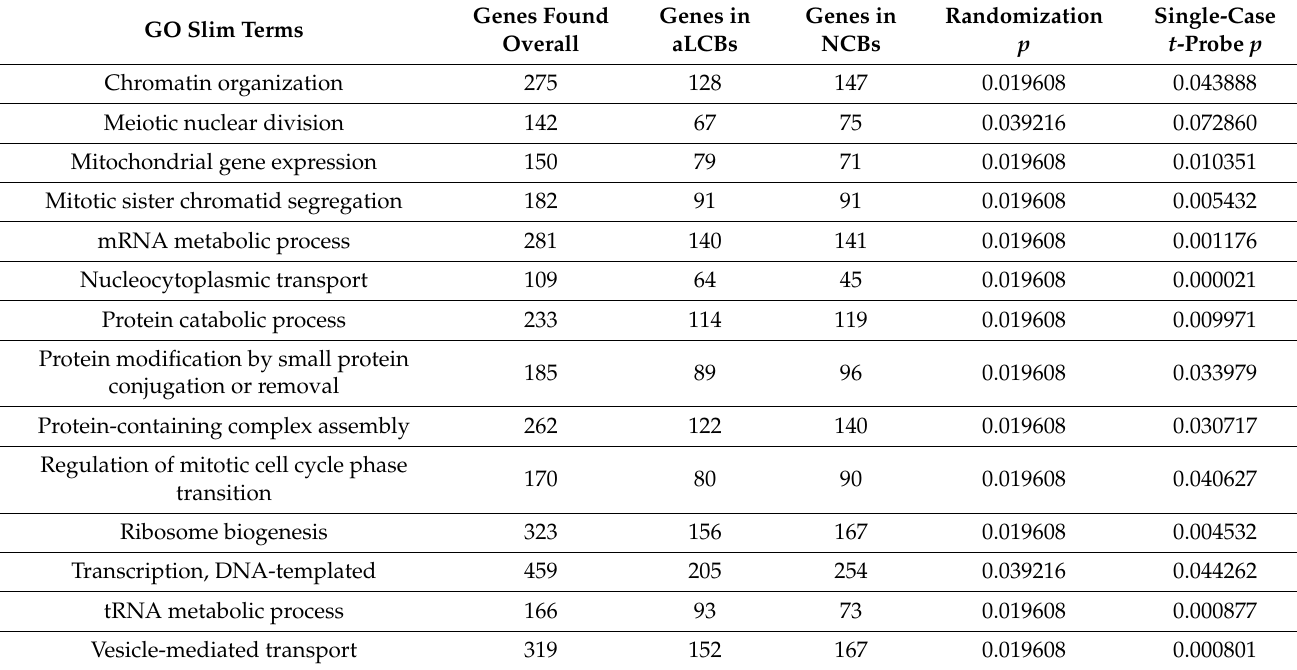
Table 2. List of the 14 significant GO categories that are overrepresented in the aLCBs. The GO term meiotic nuclear division are not significant according to the single-case t